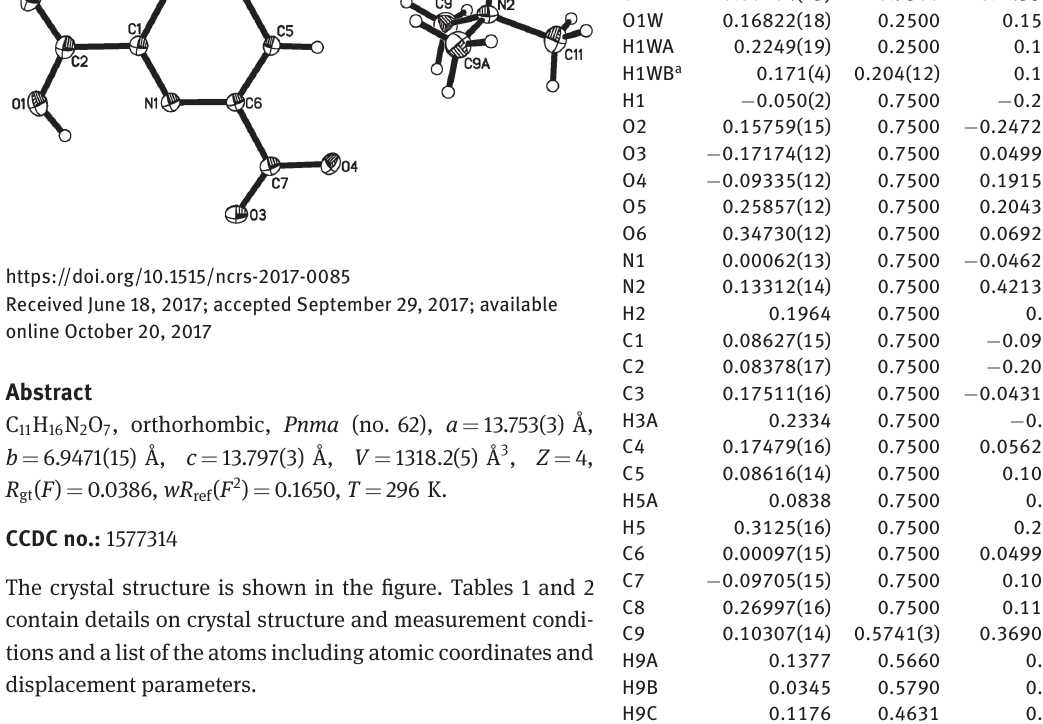
Table 1: Data collection and handling.